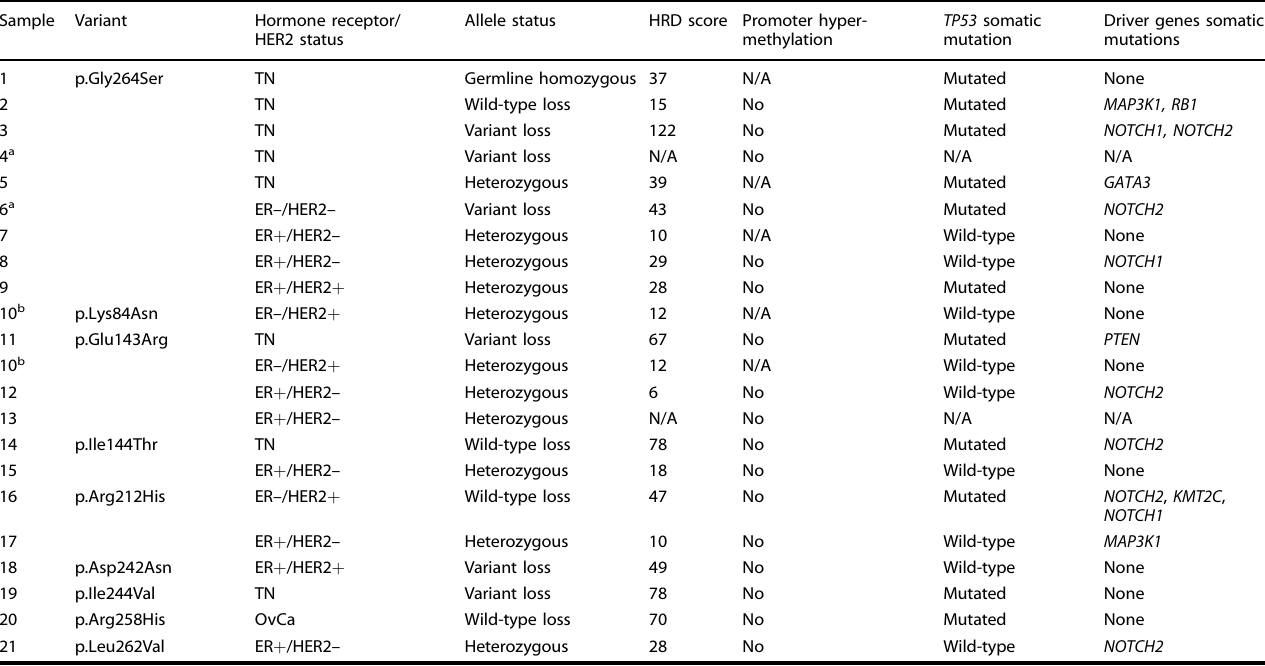
Table 2. Molecular analysis of 21 tumours from RAD51C MS variant